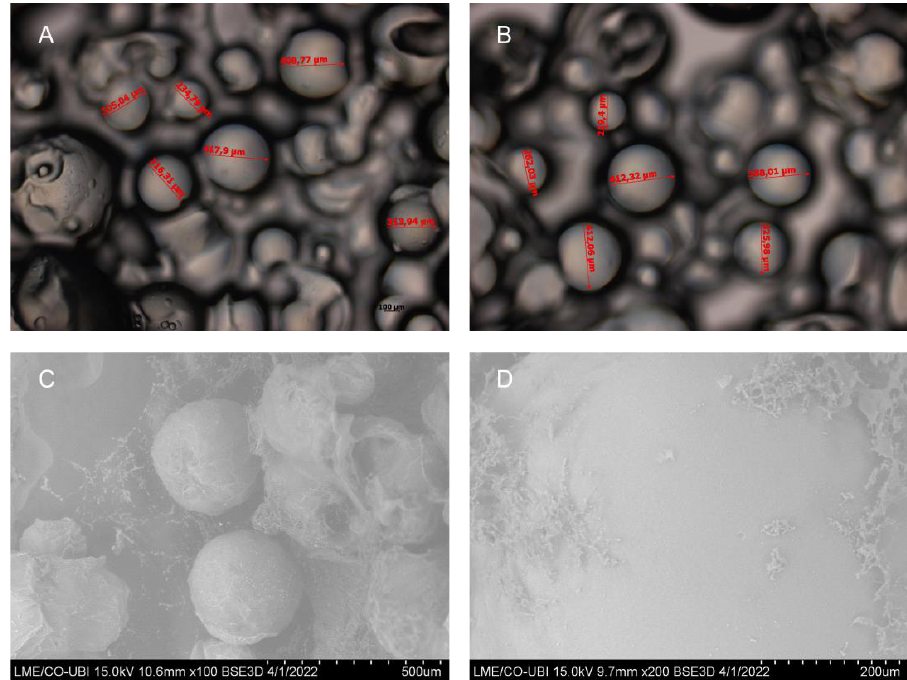
Figure 1. Semi-optical snapshots of calcium-crosslinked GG microspheres ( A , B ) and SEM images at ×100 magnification ( C ) and ×200 magnification ( D ).